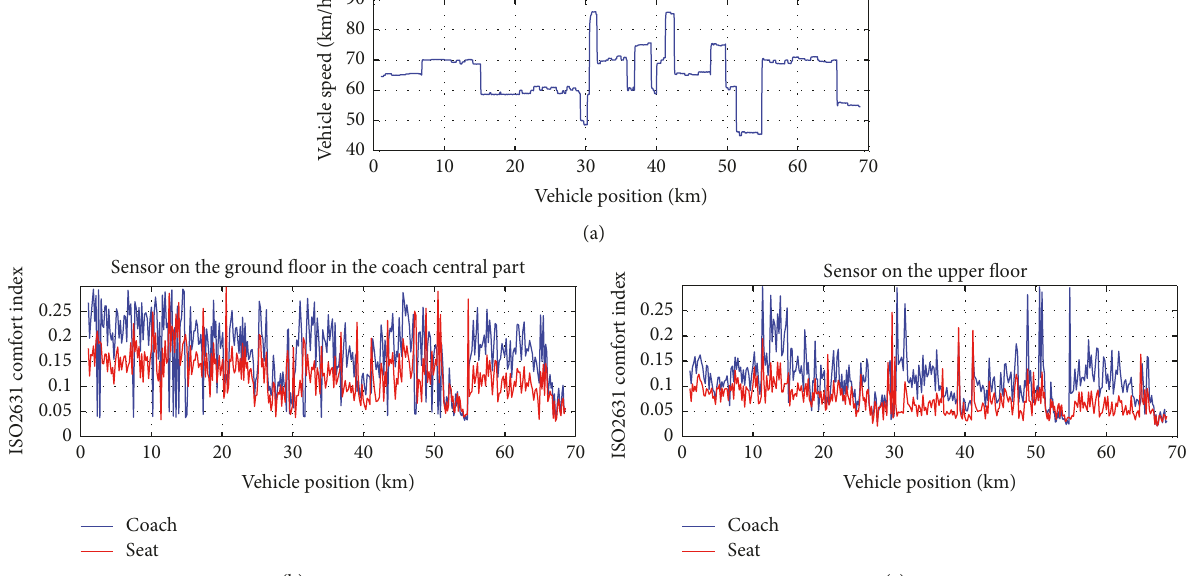
Figure 24: Comfort index evaluated on different points of the coach.